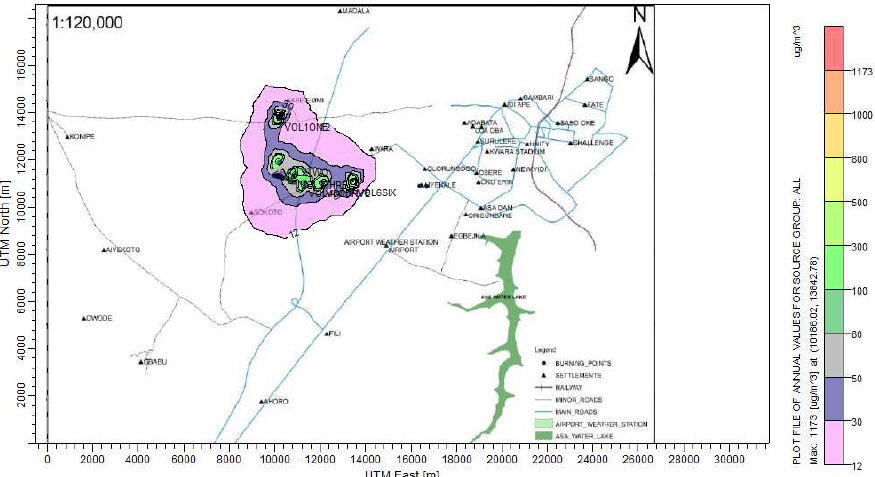
Figure 12. Isopleth of annual ground level SO x from Sokoto-Aiyekale dump